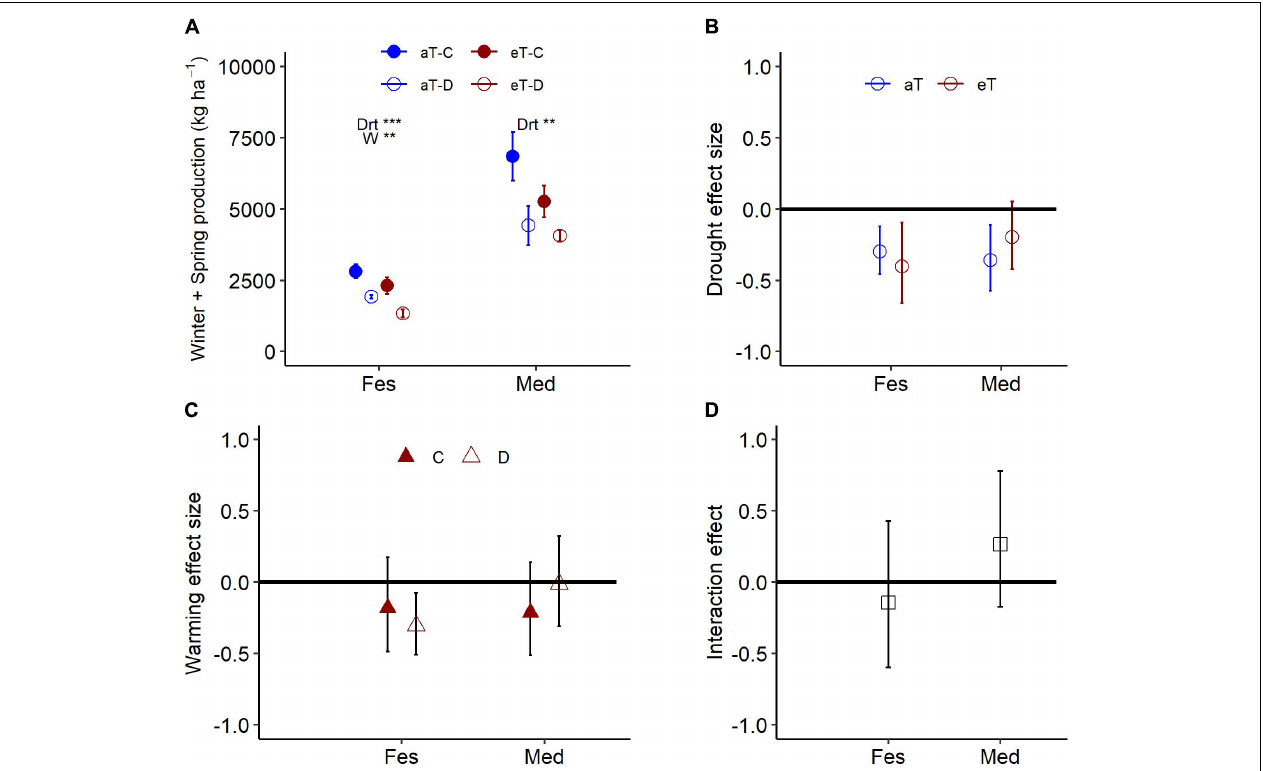
FIGURE 6 | Aboveground production for Festuca and Medicago exposed to the combined effects of drought (control: C and droughted: D) and warming (ambient: aT and elevated: eT) treatments during (A) the 6-month winter/spring drought period. Treatment effect sizes during the winter/spring drought period for (B) drought under ambient (also shown in Figure 4 ) and elevated temperatures, (C) warming, under control and droughted conditions, and (D) the effect of warming on biomass responses to drought [for panel (D) , positive values indicate a reduction in drought impact under warming]. Values in panel (A) are means ± 1 SE; while panels (B–D) are means and 95% confidence intervals. Spp. abbreviations and significance levels follow Figure 4